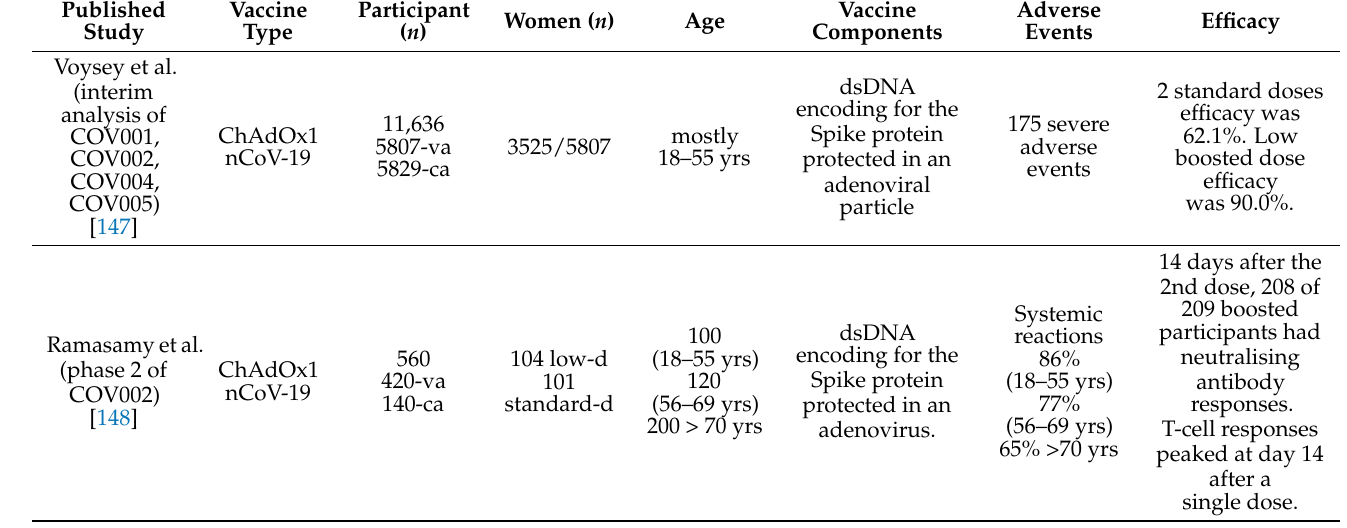
Table 4. Selected studies investigating efficacy and adverse events of most administered anti-SARS-CoV-2 vaccines worldwide. For each study, the total participants number, women/total number and age are presented as baseline characteristics. Major findings have been divided into two columns: adverse events and efficacy data in terms of prevention of Covid-19 and antibodies titers. Data are number